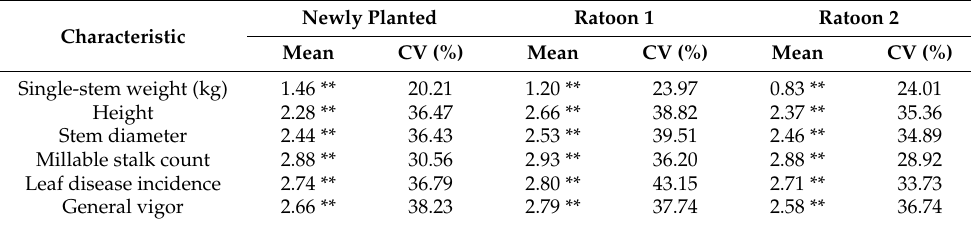
Table 3. Variance analysis of the agronomic characteristics in 107 sugarcane varieties.